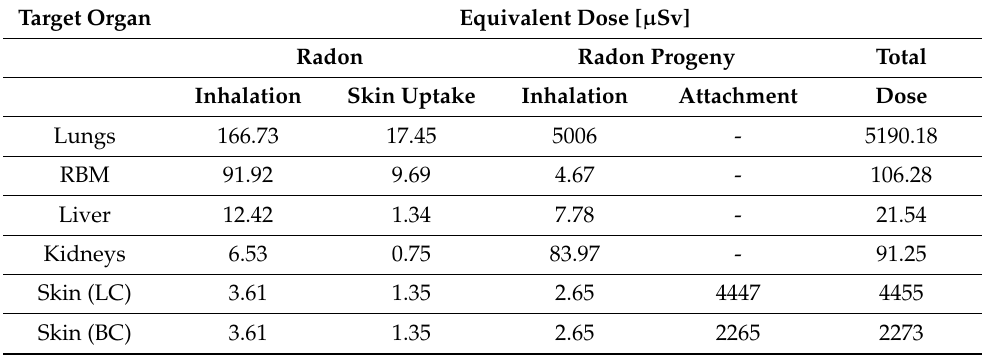
Table 8. Comparison of organ doses received in the thermal gallery for different exposure pathways. Target